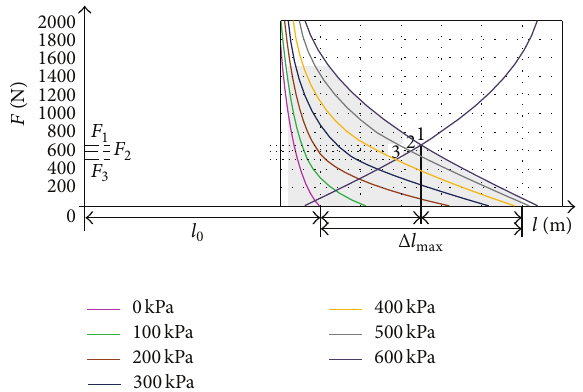
Figure 3: Static characteristics (force-length relationship) of PAM- based actuator. Equilibrium points are located at the intersections of force curves for given muscle pressures. As is shown in the figure, one of the muscles remains inflated to the initial pressure and is not activeinonehalfoftheoperatingrangeofrotationaljointmovement (in the figure, 𝐹 is muscle force, 𝑙 is muscle length, 𝑙 0 is initial muscle length, Δ𝑙 max is maximum range of muscle length change, and 𝑃 is muscle pressure).